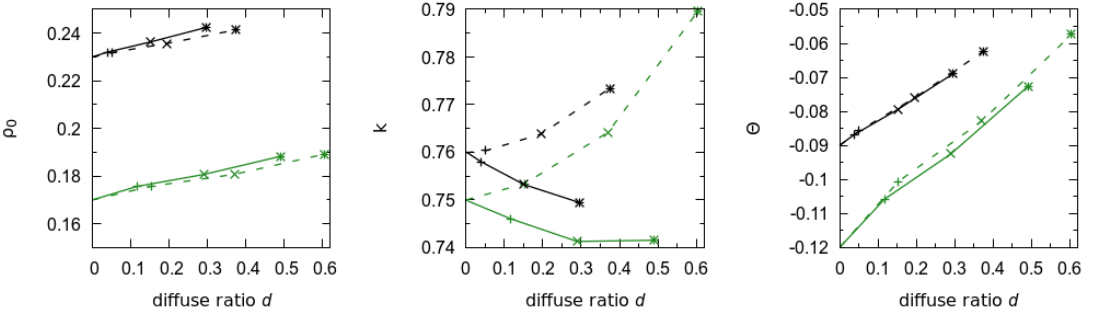
Figure 3. Effects of increasing aerosol optical depth τ 550 (or diffuse ratio d ) on the optimization of the RPV function as performed on simulated HDRF, at 0.55 µ m (green plot) and 0.87 µ m (black). Solid lines refer to a θ i of 20 ◦ , dashed lines to θ i = 50 ◦ . RPV parameters used for the forward principal plane simulation correspond to the values inverted in the case of d = 0. For each set of points the τ 550 assumes the values 0.05 (+), 0.3 ( × ) and 0.7